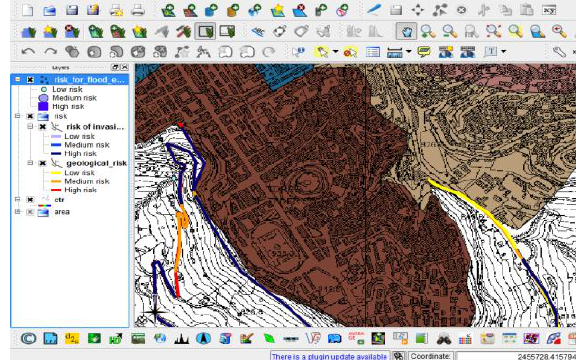
Figure 13. Hydrological risk of road